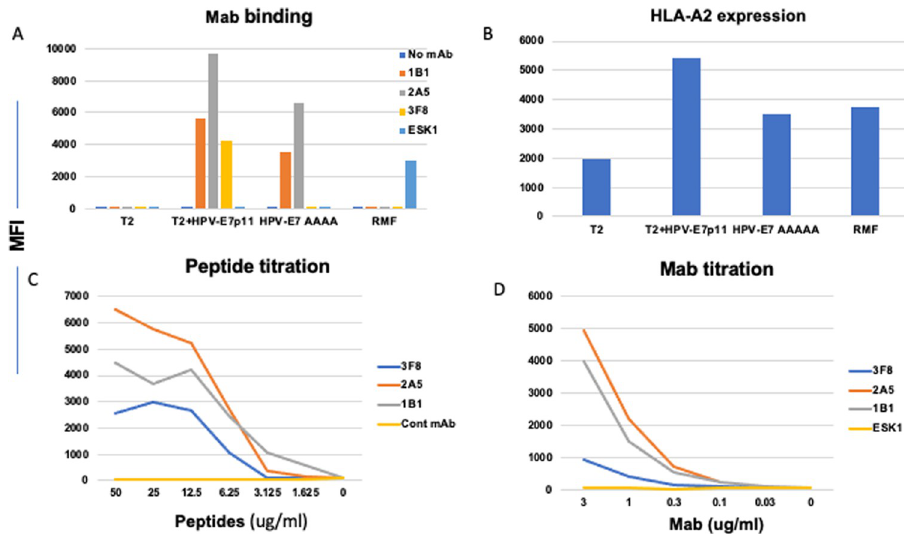
Fig 1. Binding of the mAbs to the HPV-E7p11-19/HLA-A2 complex. [A] Binding of mAbs to T2 cells pulsed with or without peptides. HPV-E7p11, HPV-E7AAAA or, WT1-RMF peptide at a concentration of 20ug/ml was pulsed onto T2 cells overnight in serum-free RPMI1640 complete medium. Cells were washed and stained with the mAbs 1B1, 2A5 or 3F8 conjugated to APC at a concentration of 3ug/ml. A control TCRm mAb specific for WT1-RMF/HLA-A2 complex, ESK1, was used as a negative control for HPV mAb, but positive assay control for RMF/HLA-A2 complex. In parallel, HLA-A2 expression stabilization was determined by staining the cells with anti-HLA-A2 mAb BB7 clone [B]. Binding potency of the mAbs was measured by titrating the HPV-E7p11-19 peptide at the indicated concentrations onto T2 cells; the cells were stained with indicated mAbs at 3ug/ml [C]. Mab titration was performed for relative avidity on T2 cells pulsed with HPV-E7p11-19 peptide at 20ug/ml and stained with the indicated mAbs at concentrations ranging from 3ug/ml to 0.03ug/ml] [D]. All binding was determined by flow cytometry and indicated by median fluorescence intensity [MFI].